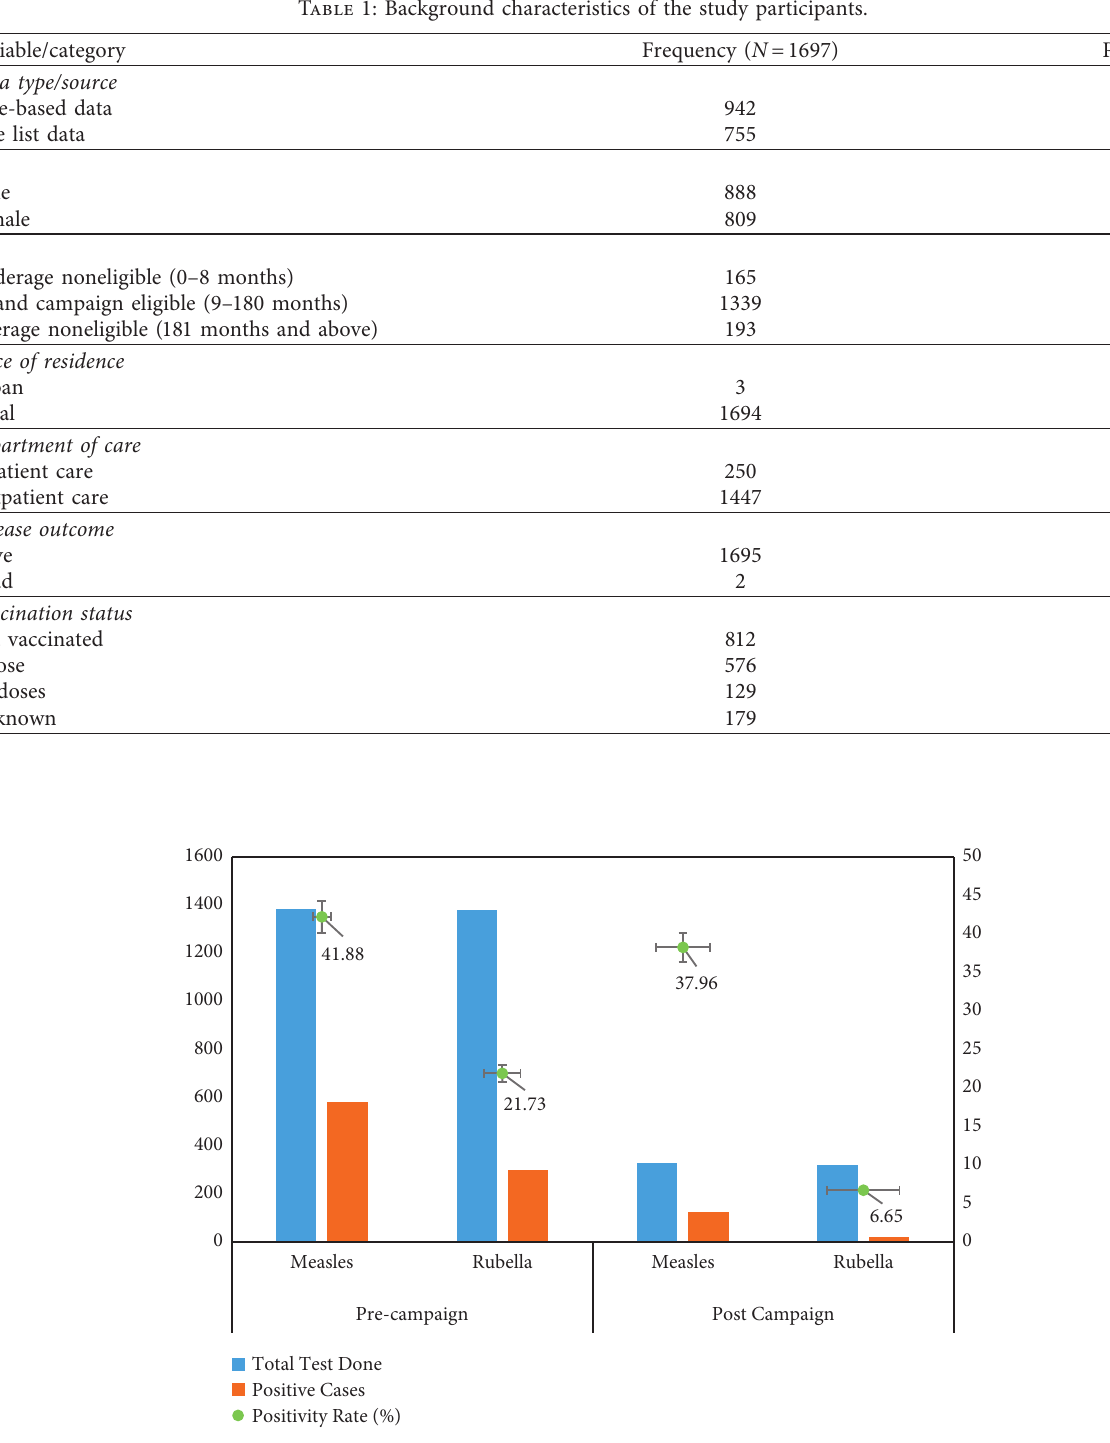
Figure 1: Measles-rubella percent positives in pre-mass and post-mass vaccination periods.